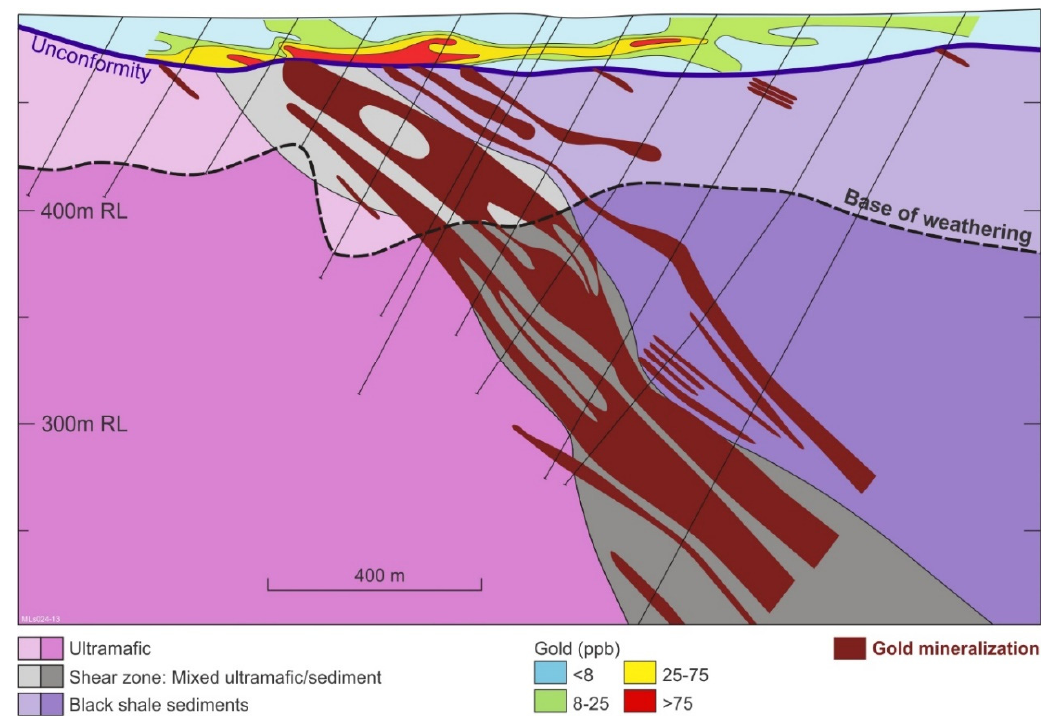
Figure 3. Stylized cross-section through the regolith showing geology, mineralization and anomalous Au in bedrock, saprolite and paleochannel transported cover (Line 6912700N). An unconformity marks the boundary between transported cover and in situ regolith. Based on regolith and geochemical data supplied by Regis Resources. N.B. Vertical exaggeration has been applied to this diagram.